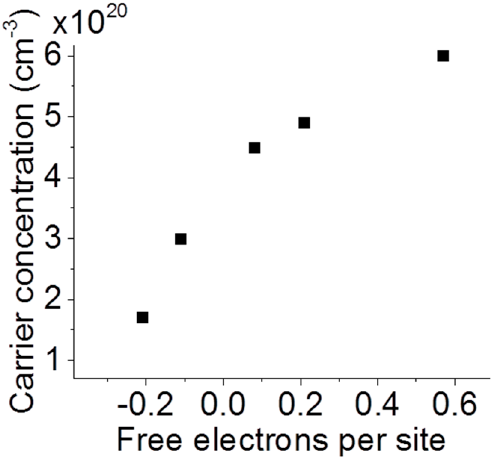
Figure 4. Localized surface plasmon resonance inferred carrier concentration versus number of free electrons per metal site in La x Eu 1 − x B 6 .